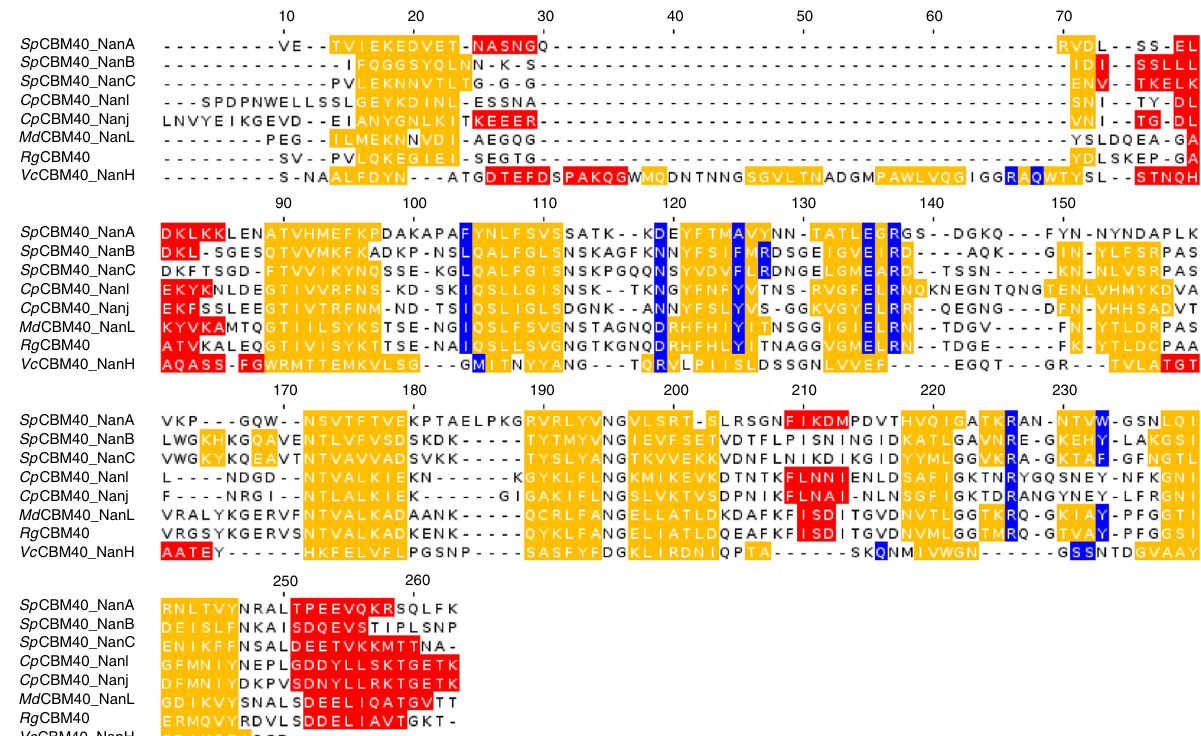
Fig. 2 CBM40 structural alignment. Structure-based alignment ( α -helices and β -strands respectively in red and yellow) of CBM40 domains of Rg CBM40 with C. perfringens Cp CBM40_NanJ (PDB code 2V73) and Cp CBM40_NanI (PDB code 5FRA), M. decora Md CBM40_NanL (PDB code 1SLI) and S. pneumoniae Sp CBM40_NanA (PDB code 4C1W), Sp CBM40_NanB (PDB code 2VW0) and Sp CBM40_NanC (PDB code 4YZ5) and Vc CBM40_NanH structure (PDB code 2W68). Amino acids identi fi ed as binding sites are highlighted in blue. Rg CBM40 residues Ile95, Asp110, Tyr116, Glu126, Arg128, Arg204 and Tyr210 are at positions 104, 119, 125, 135, 137, 226 and 233 of the alignment. The alignment supplemented with other canonical and Vibrio -type CBM40 sequences, used to create the pHMM using HMMER3, is shown in Supplementary Fig.